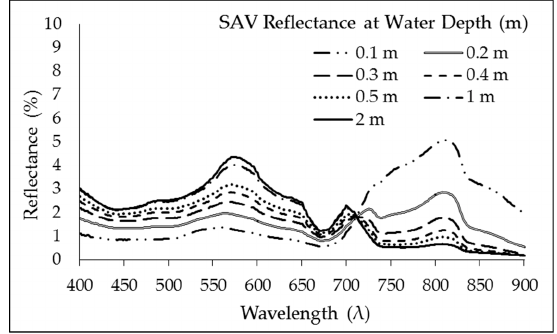
Figure 11. Simulated reflectance spectra of SAV at a varying water depth (0.1 m to 2 m).